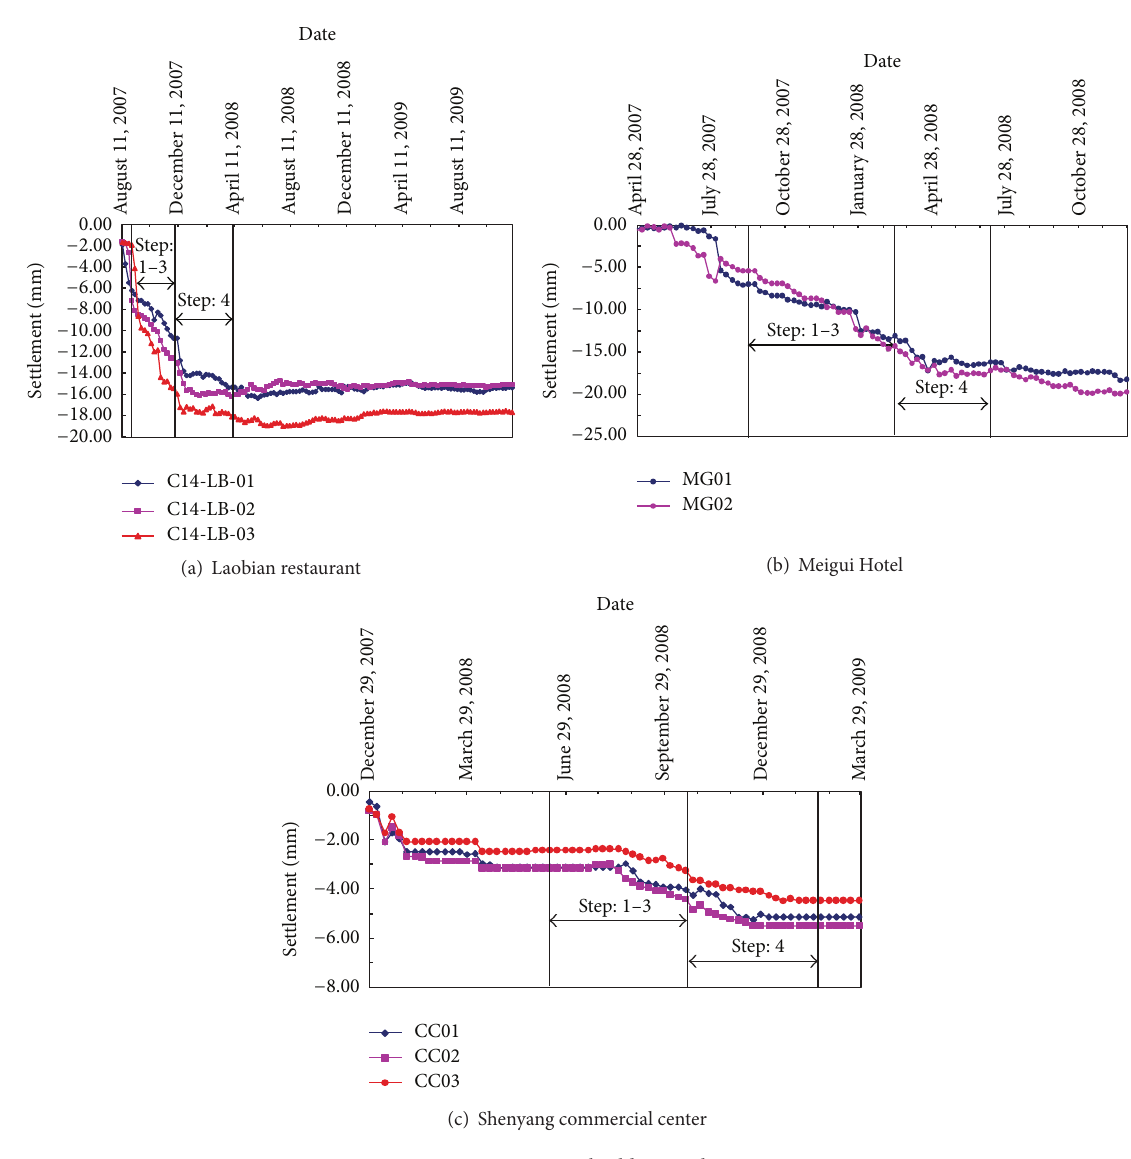
Figure 18: Long-term building